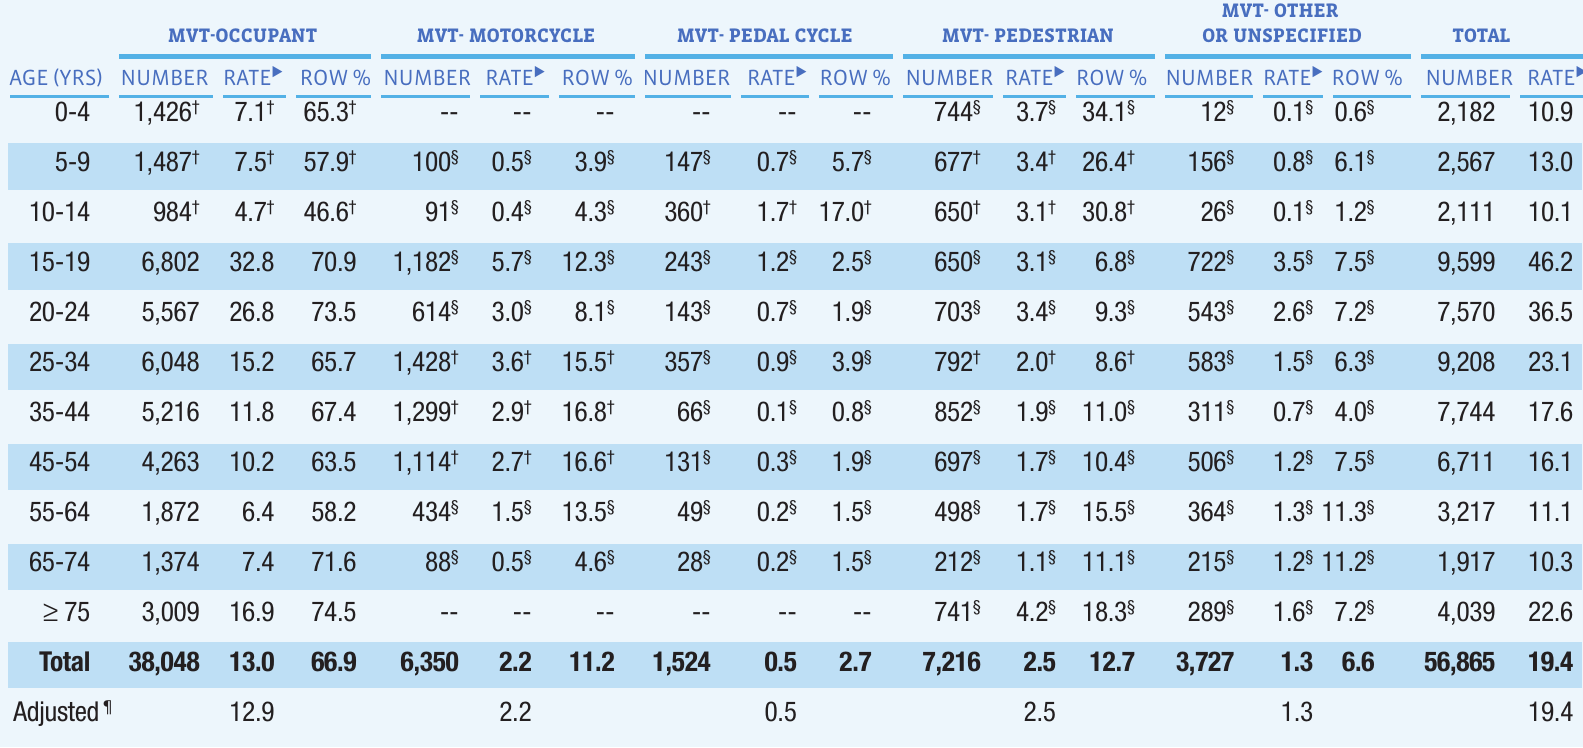
TABLE 12: Estimated Average Annual Numbers, Rates, and Percentages of Traumatic Brain Injury- Related Hospitalizations, by Age Group and Specific Motor Vehicle–Traffic (MVT) External Causes, United States,